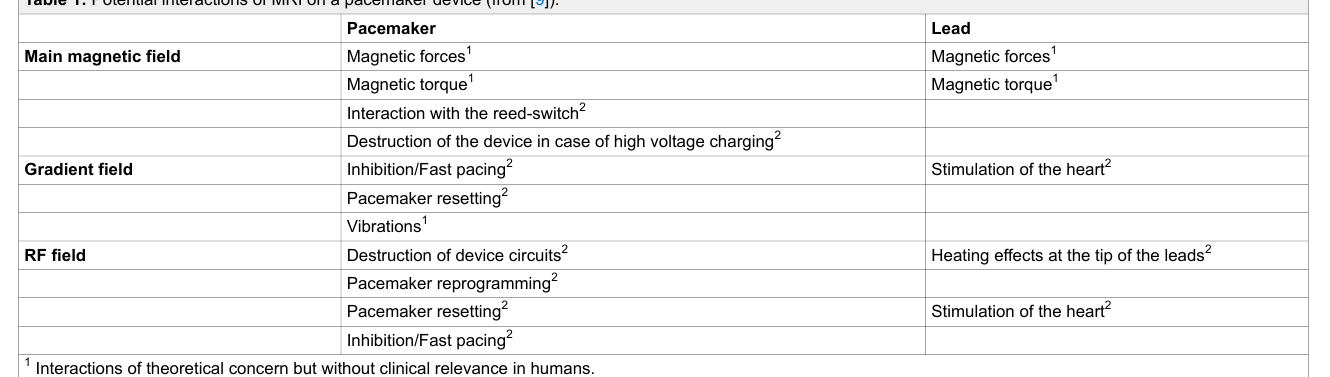
Table 1: Potential interactions of MRI on a pacemaker device (from [9]). Pacemaker